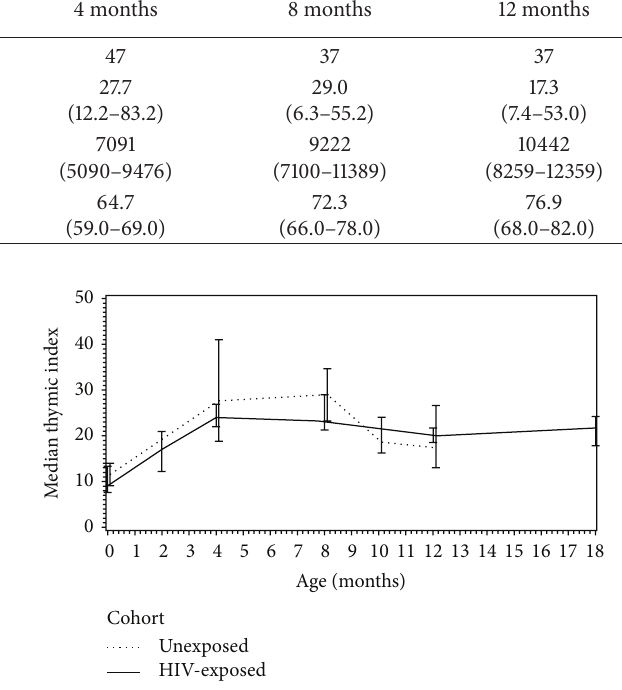
Figure1:ThethymicsizeinHIV-EUinfantscomparedtotermHIV- unexposed infants. In general, there is no difference in thymic size between the cohorts from birth to 12 months of age when feeding mode is not included in the analysis. The Ti is given as median and with Q 1 and Q 3